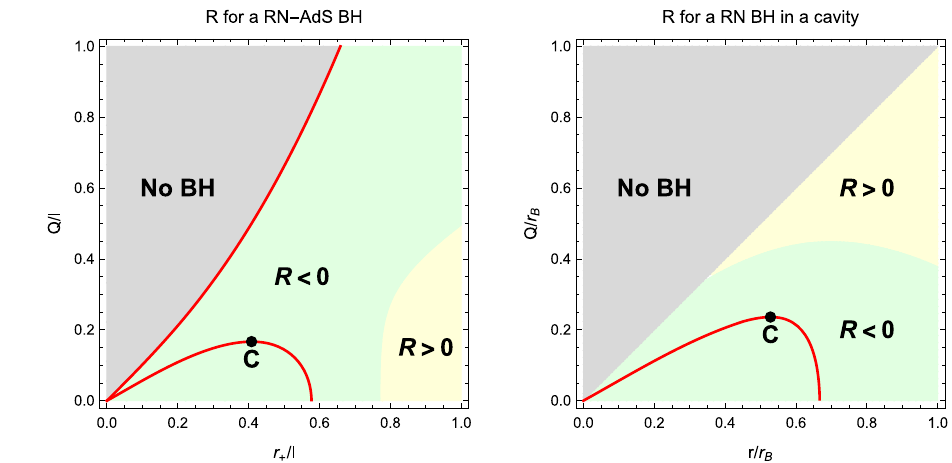
Fig. 1 The Ruppeiner invariant R as a function of the outer horizon radius r + and the charge Q . Left Panel For a RN-AdS black hole, where l is the AdS radius. Right Panel For a RN black hole in a cavity, where is r B the radius of the cavity. In the green (yellow) regions, R < 0 ( R > 0 ) . The red lines correspond to R = −∞ . The black dots denote the critical points, which lie on the R = −∞ lines. Black